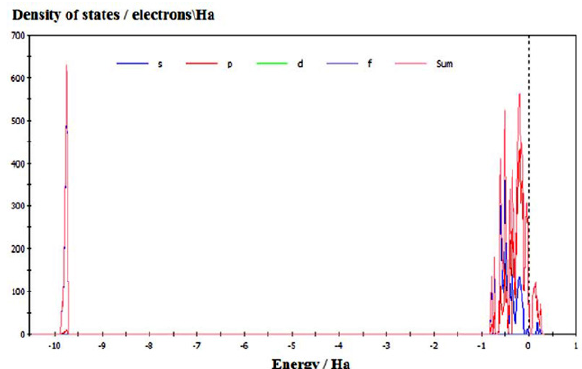
Figure 7. Calculated DOS spectra of 4-(4,5-Diphenyl-1H-imida- zole-2-yl)